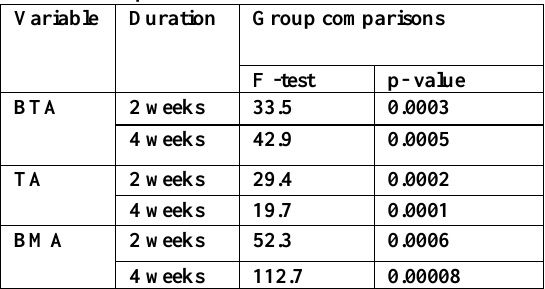
Table 1: ANOVA group comparisons for bone parameters.